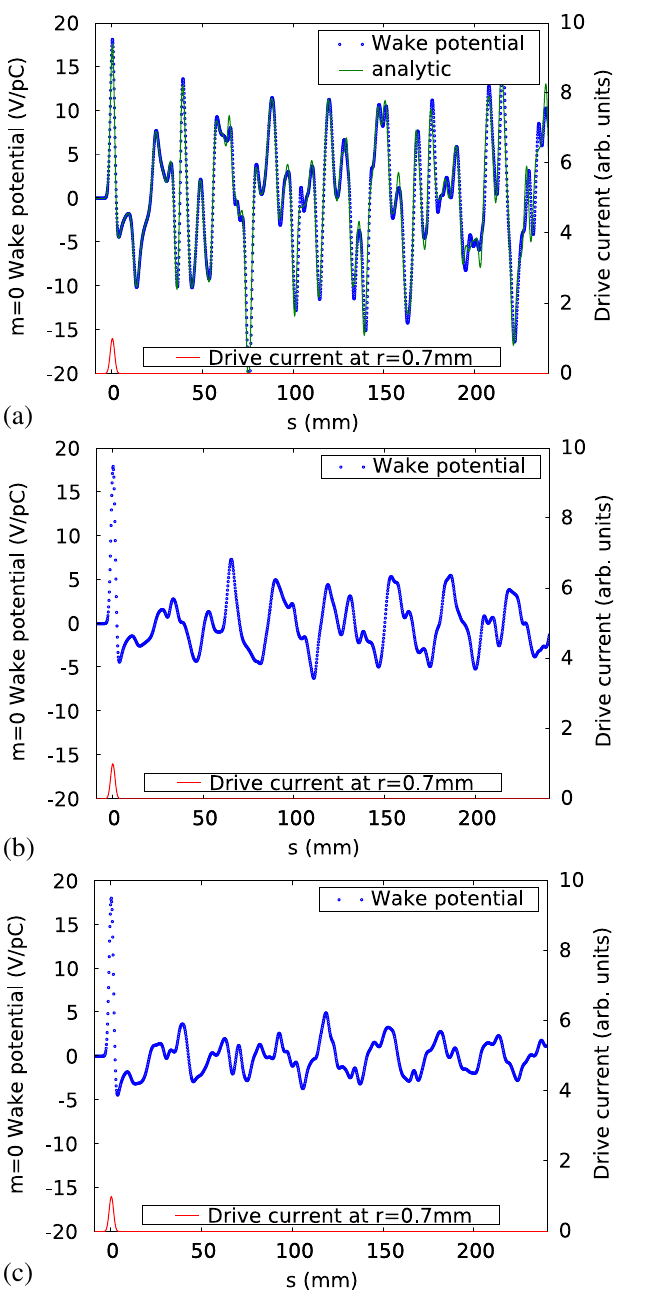
FIG. 4. (Color) Monopole wake potentials in the (a) closed pill- box cavity, (b) PhC cavity, and (c) optimized PhC